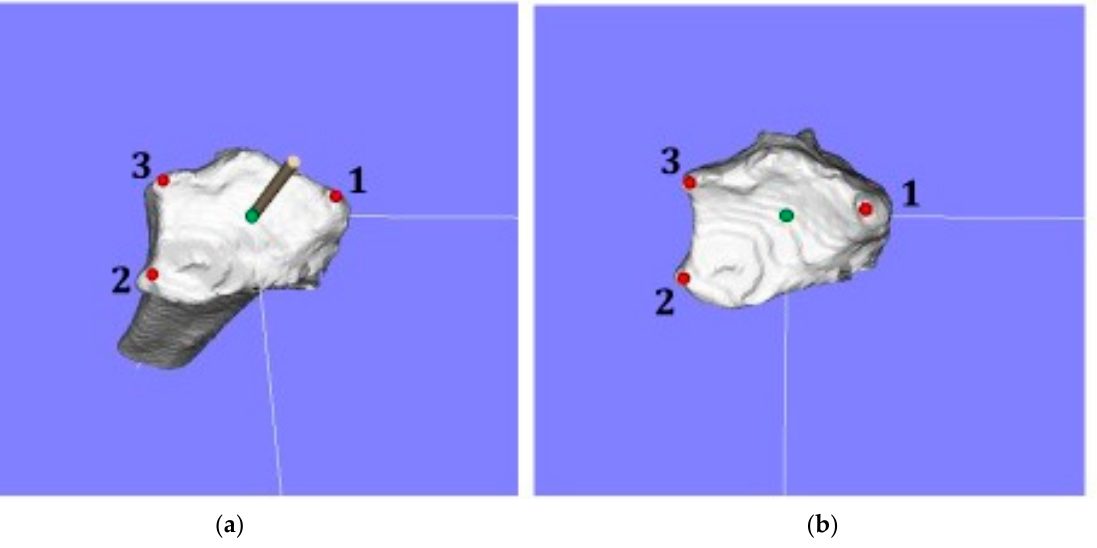
Figure 1. Three reference points on 3D images. ( a ) The oblique view from the distal ulnar side and ( b ) the axial view. Red dots indicate the three reference points: (1) the radial styloid process; (2) sigmoid notch volar edge; and (3) sigmoid notch dorsal edge. The long axis of the radius was marked by the green dots and bar.